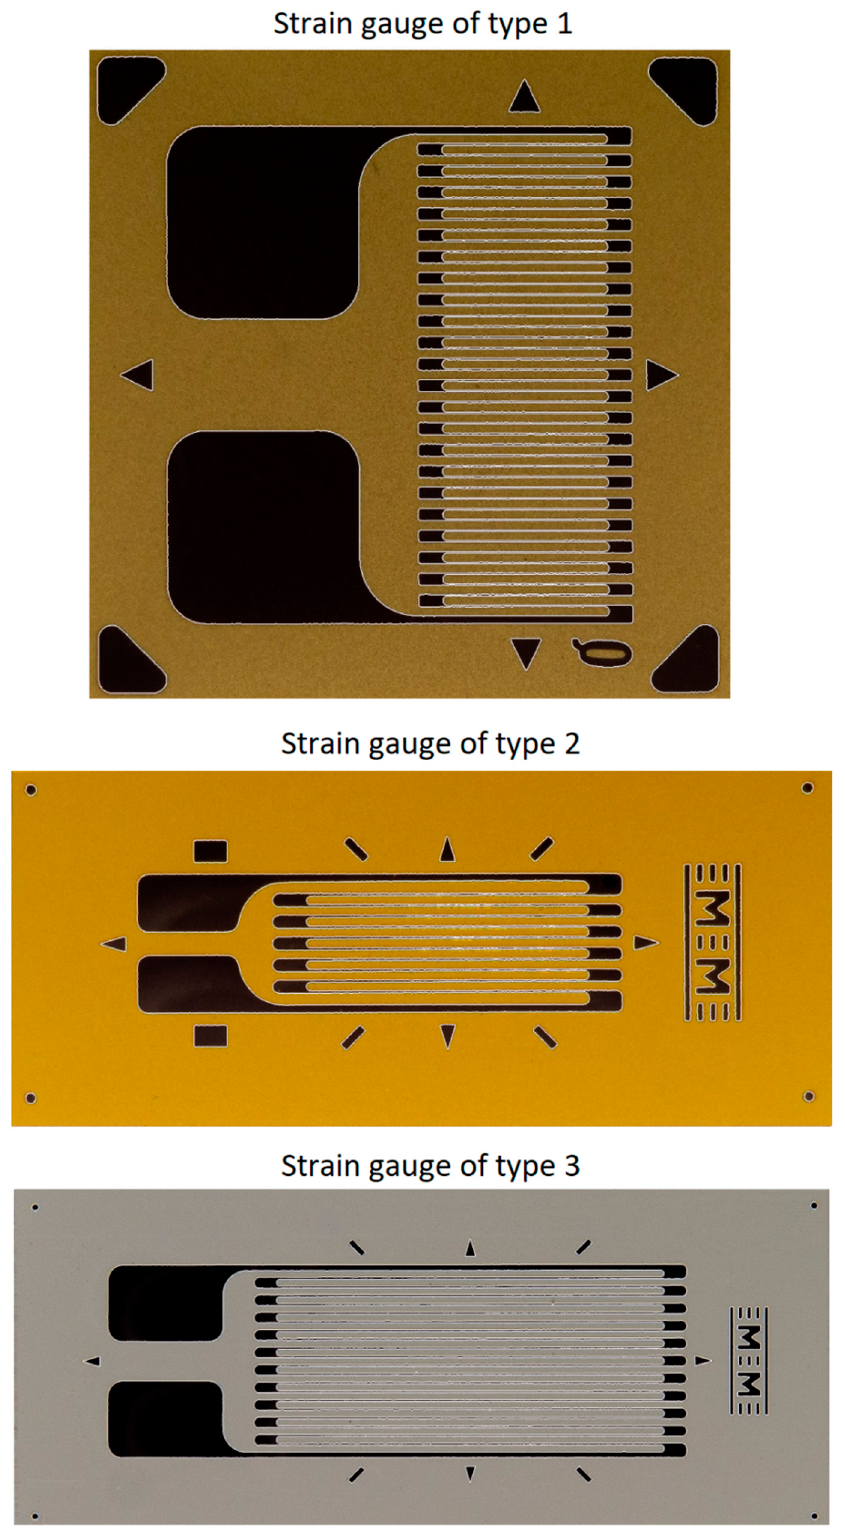
Figure 11. Extracting objects from the binary image and overlaying contours over the original image (step 4).